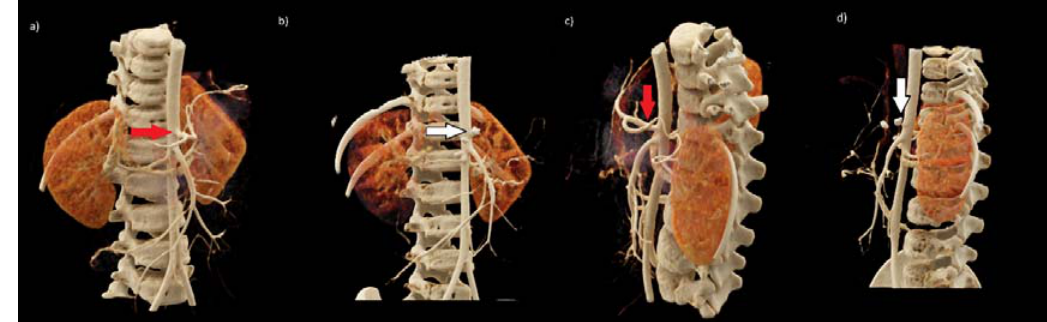
Figure 3. Preoperative ( a , c ) and postoperative ( b , d ) 3D VRT reconstructions of vessels in abdominal CT scan in the arterial phase. Red arrows ( a , c )—normal variation of the coeliac trunk with its branches. White arrows ( b , d ) note absent depiction of the coeliac trunk and its main branches. In the typical location of the coeliac trunk, there are vascular clips; nearby next two clips are visible.